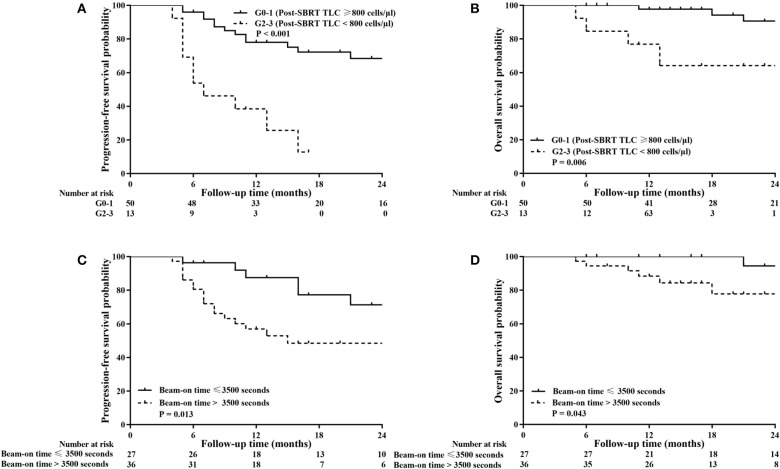
Kaplan–Meier analysis of progression-free survival (PFS) and overall survival (OS) stratified by post-SBRT lymphocyte counts (A,B) and total beam-on time (C,D). High total peripheral lymphocyte count (TLC) following SBRT and short total beam-on time were significantly associated with improved PFS (P < 0.001 and P = 0.013) and OS (P = 0.006 and P = 0.043).